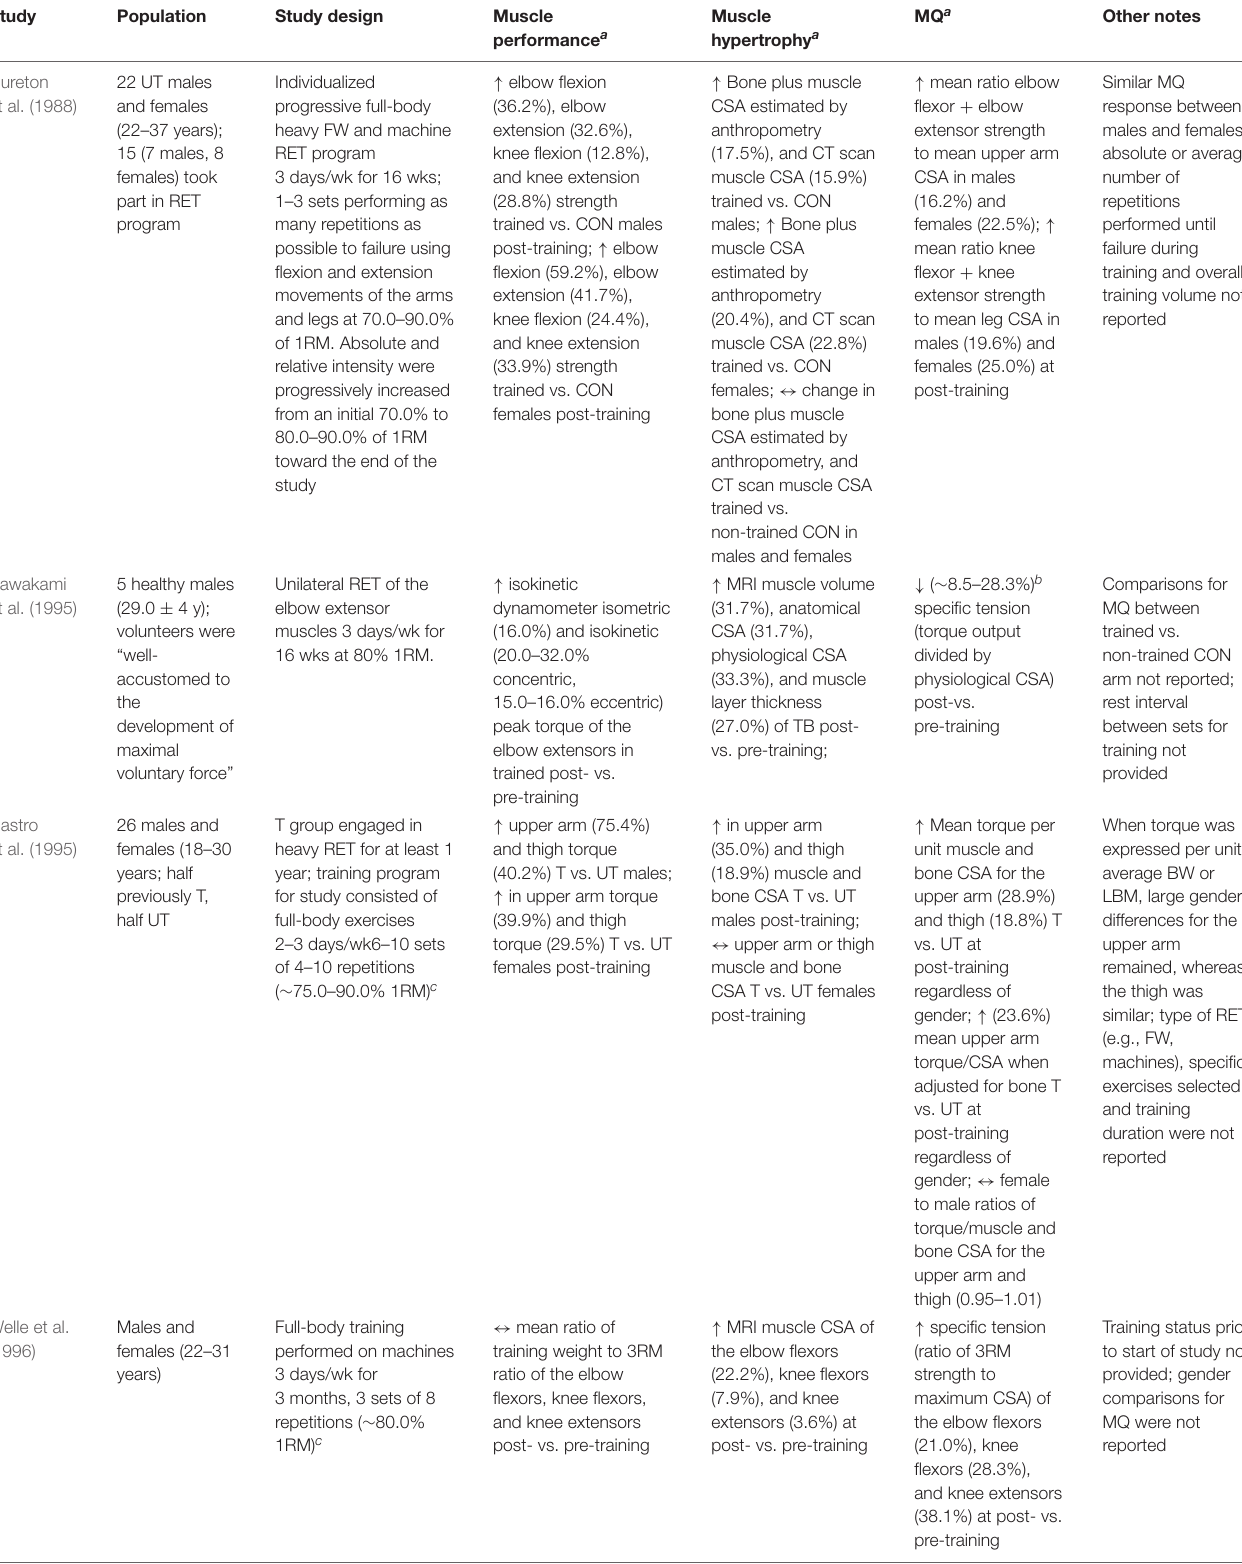
TABLE 5 | Effects of high-intensity RET on MQ, as measured by relative strength, in young (18–50 years), healthy